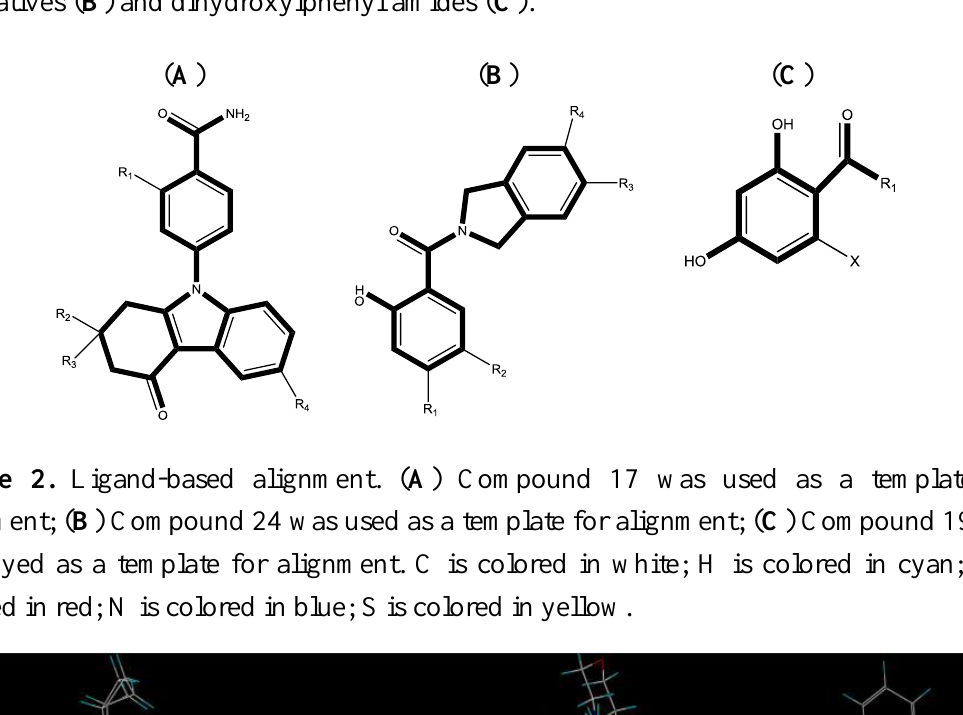
Figure 1. Skeletons for benzamide tetrahydro-4 H -carbazol-4-one analogs ( A ); AT13387 Derivatives ( B ) and dihydroxylphenyl amides ( C ).